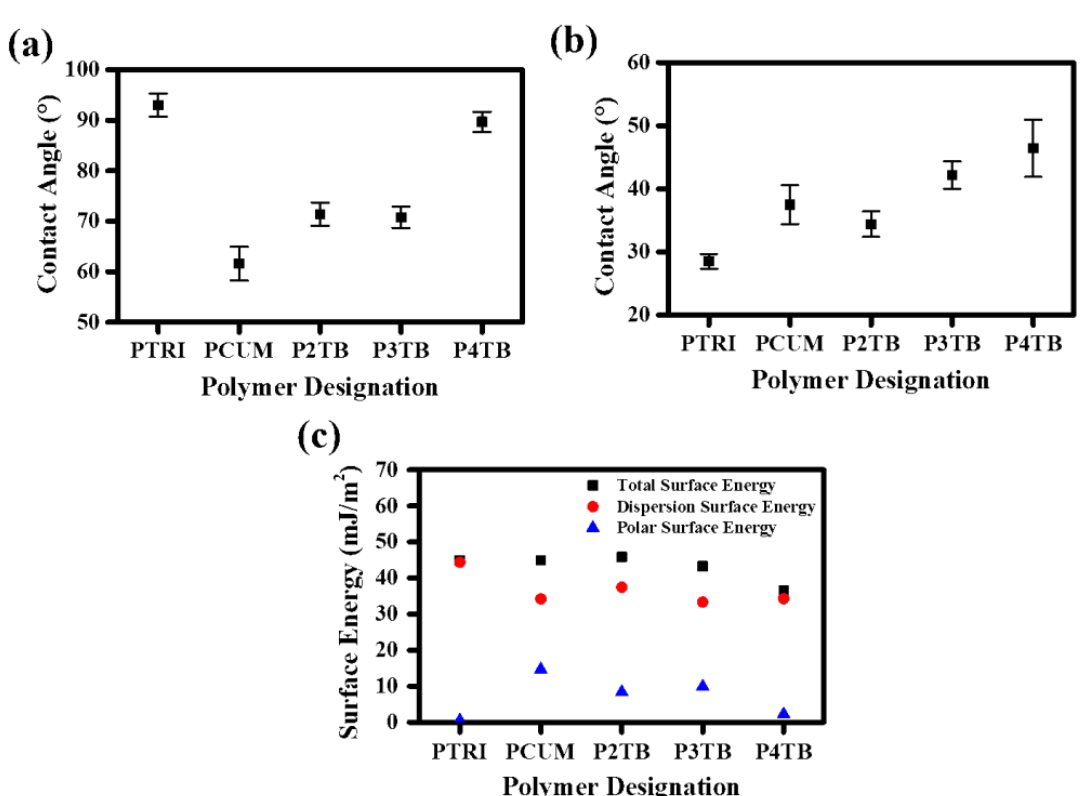
Figure 7. ( a ) Water, ( b ) diiodomethane contact angle, and ( c ) surface energy values of PTRI, PCUM, P2TB, P3TB, and P4TB films. Table 1. Surface energy values and LC alignment properties.